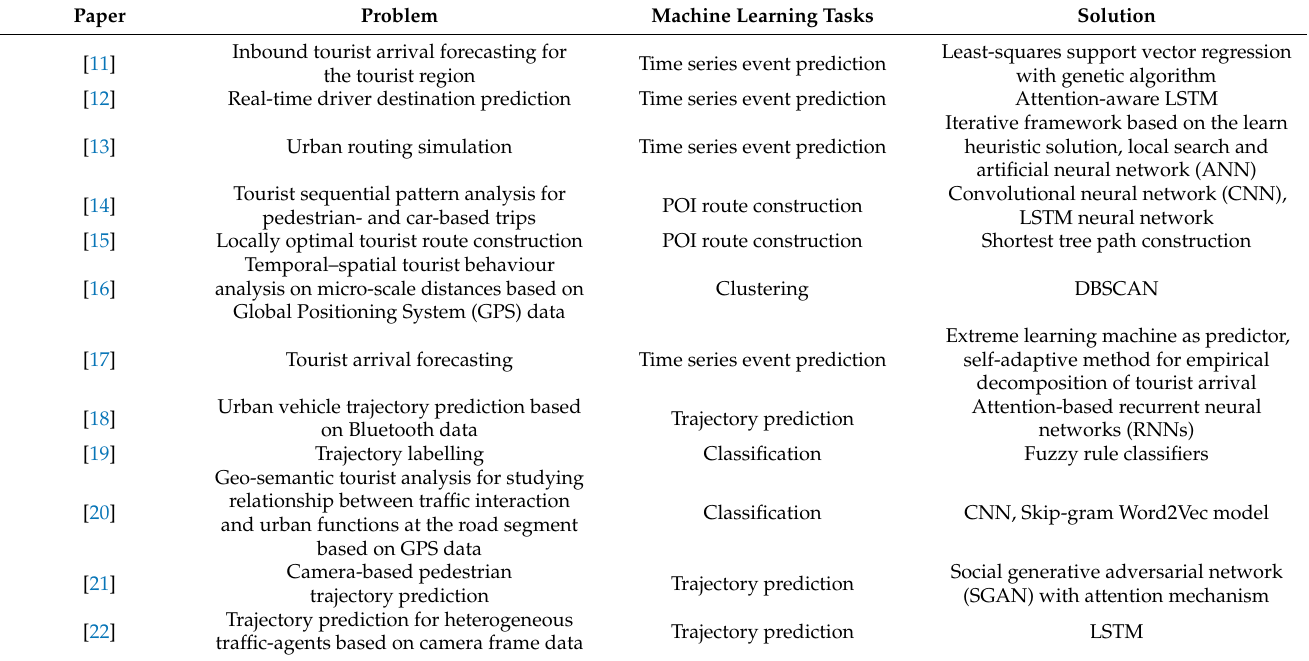
Table 1. Related work